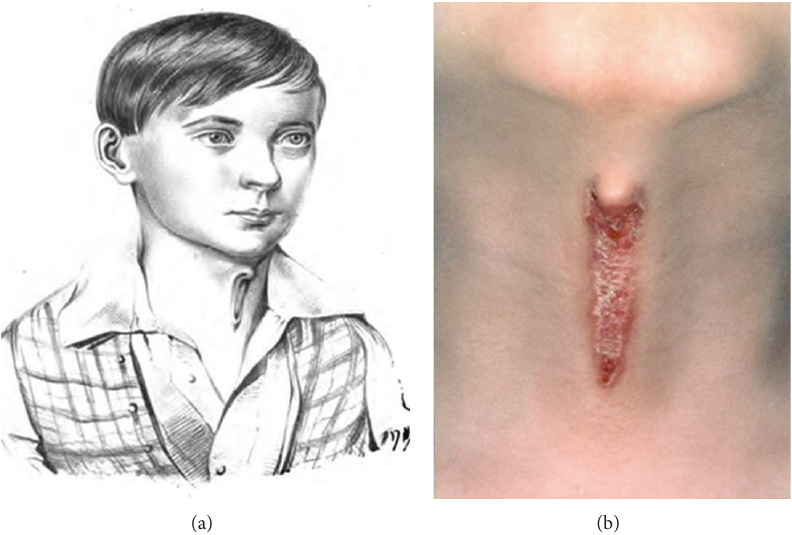
Figure 2: Consistency of presentation between a patient from 1848 (a) and the modern day